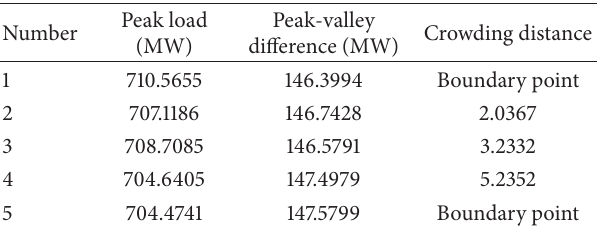
Table 3: The crowding distance of the individuals in Pareto front.